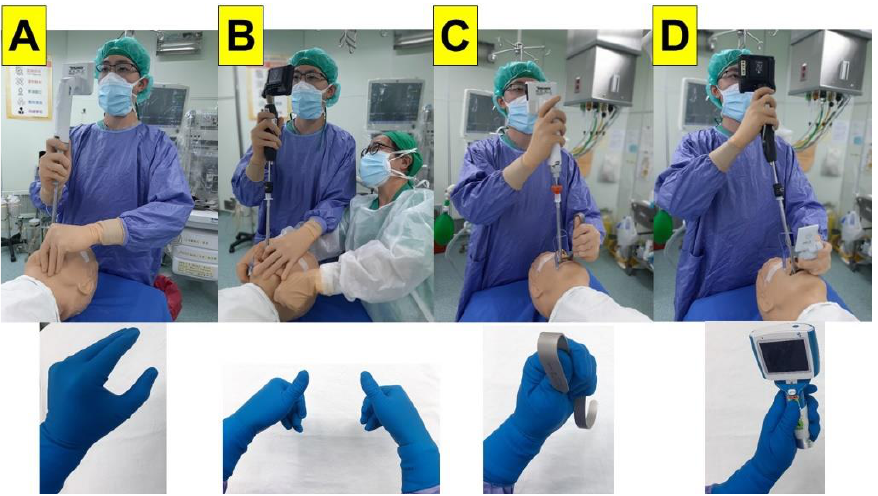
Figure 1. Typical maneuvers of using video-assisted intubating stylet technique: ( A ) classic Shikani technique. The airway operator uses his/her non-dominant hand to perform jaw-thrust; ( B ) two-handed jaw-thrust technique. The second airway operator assists opening of the airway and elevates the jaw; ( C ) use of tongue root holder/elevator to open the airway and access to the larynx; and ( D ) use of a videolaryngoscope either by the same operator or an assistant airway manager. Intubating devices: Trachway ( A , C ); C-MAC-VS ( B , D ); McGRATH™ MAC ( D , upper panel); UE ( D , lower panel).